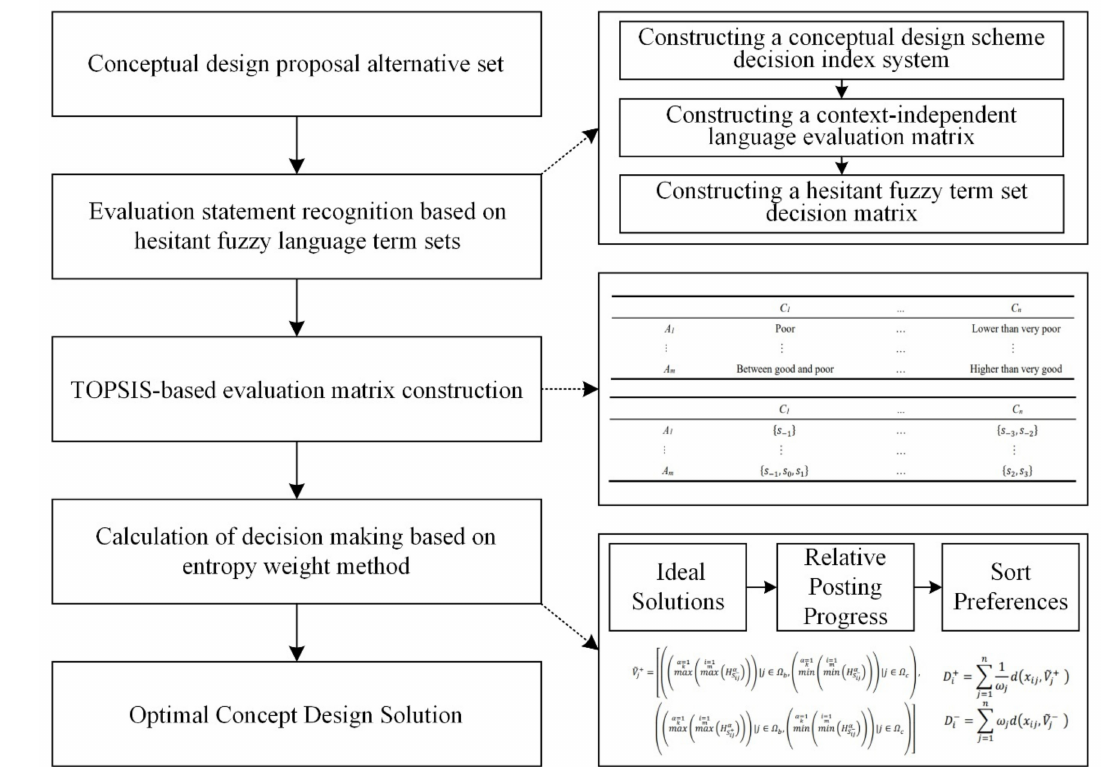
Figure 3. TOPSIS-based product conceptual design solution decision flow